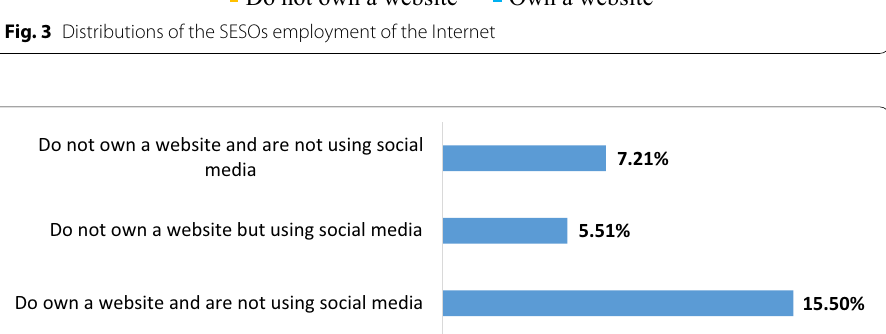
Fig. 3 Distributions of the SESOs employment of the Internet